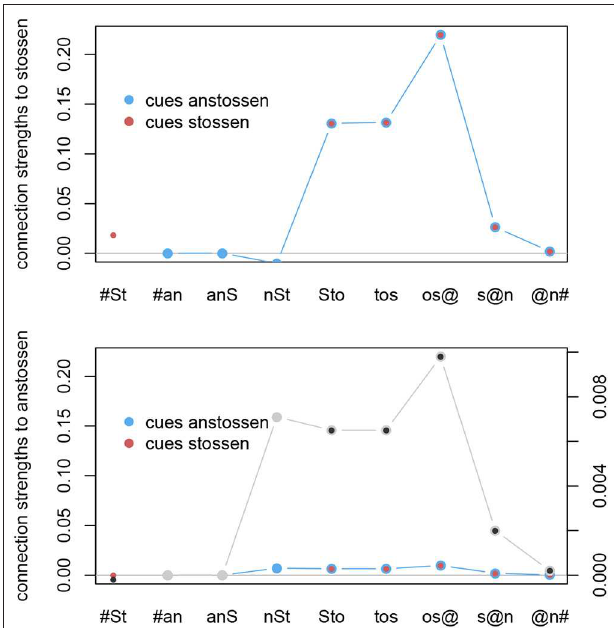
FIGURE 6 | Connection weights from triphones to the lexome STOSSEN (upper panel), and to the lexome ANSTOSSEN (lower panel). As the primes are of much lower frequency of occurrence than the targets, the magnitude of weights in the lower panel is substantially reduced compared to the upper panel. In the lower panel, the blue and red disks are presented on the same scale as the upper panel. The disks in gray and black represent the same datapoints, but now on an enlarged scale, depicted at the right-hand side of the